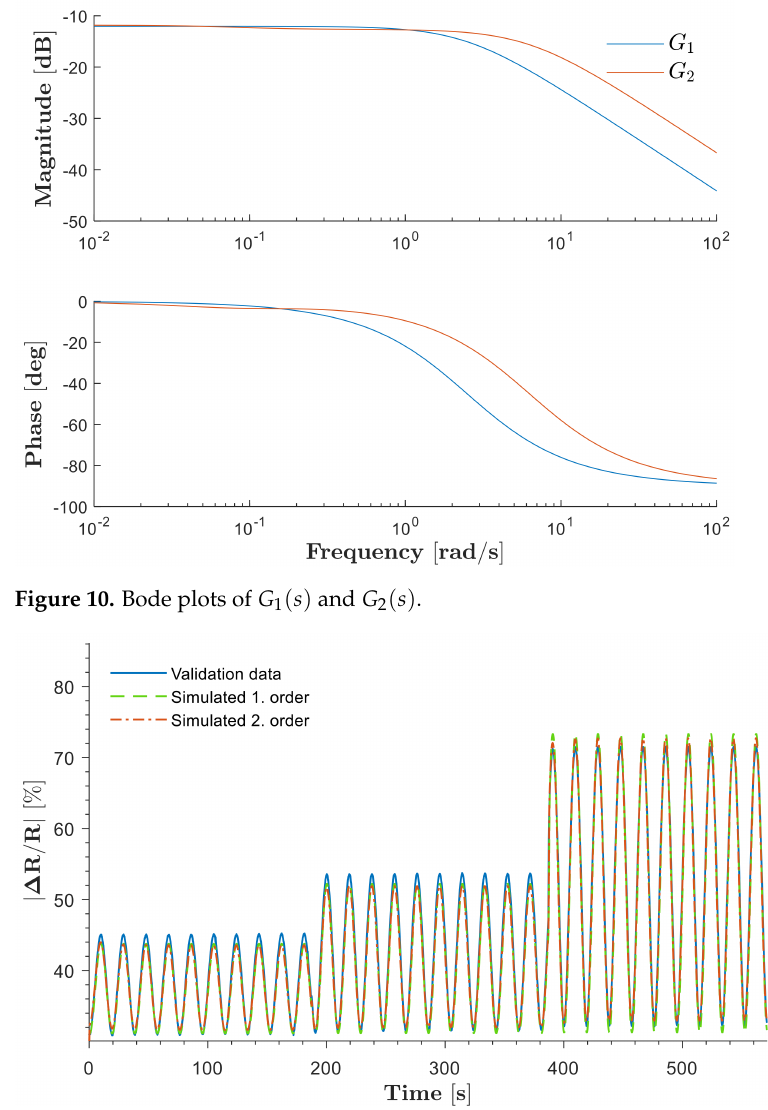
Figure 11. Dynamic model validation under various cyclic loading